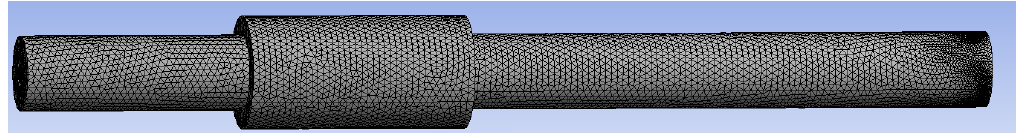
Figure 1. Schematic diagram of right-angle expansion model in horizontal section.